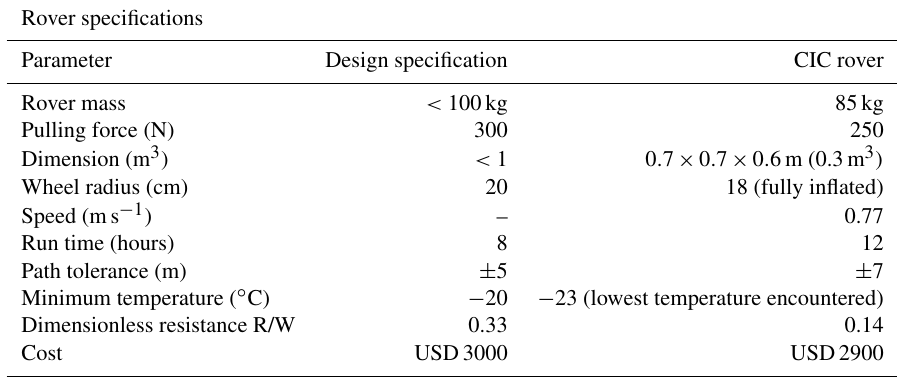
Table 2. Summary of CIC rover design parameters and measured performance in the field. Rover